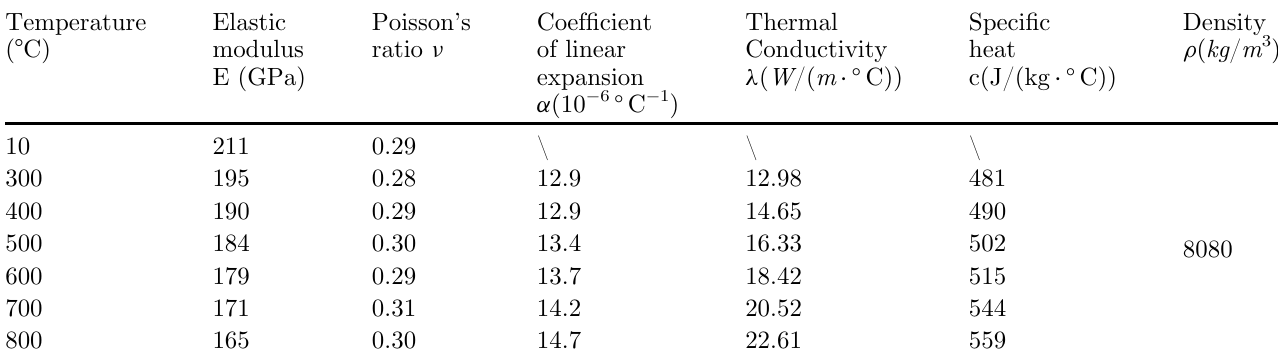
Table 2. Temperature dependence of thermodynamic parameters of K418B superalloy [14].